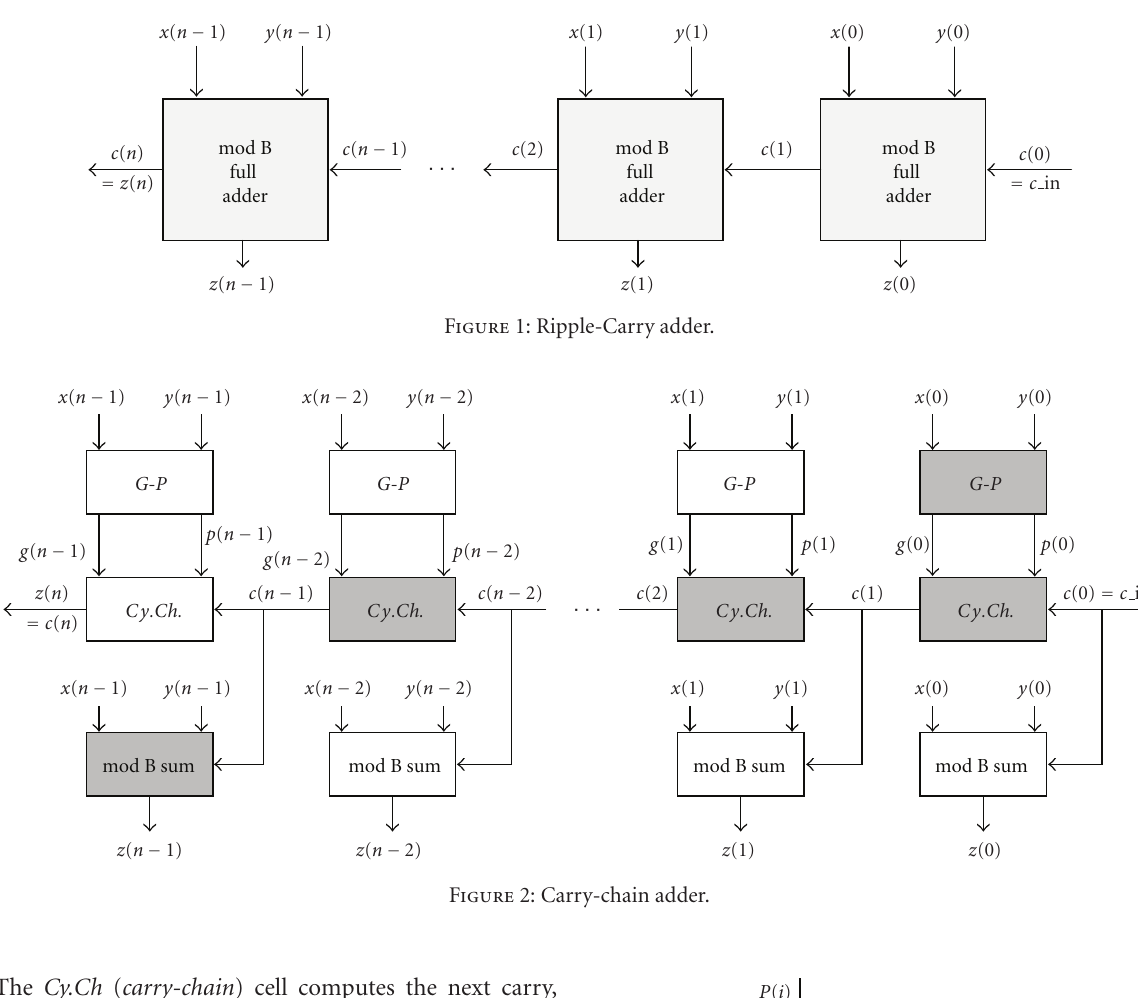
Figure 2: Carry-chain adder.